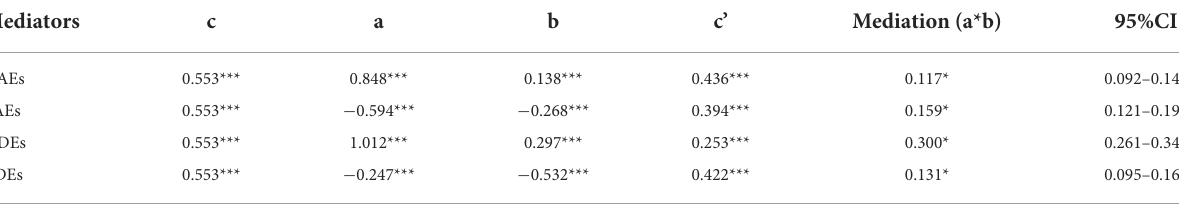
TABLE 5 The mediating role of GAEs on the associations between procrastination and